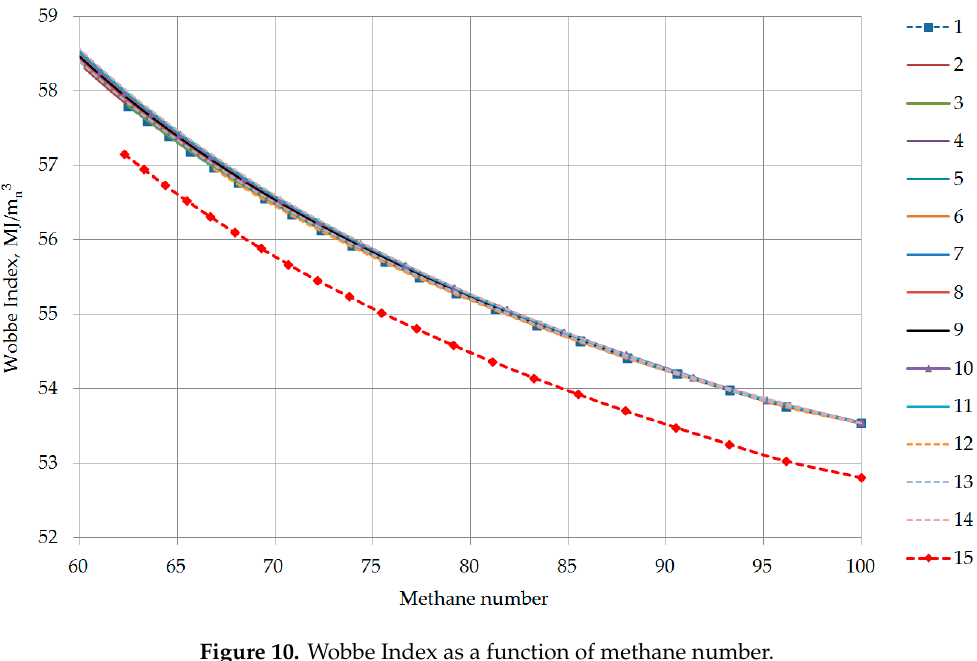
Figure 10. Wobbe Index as a function of methane number.